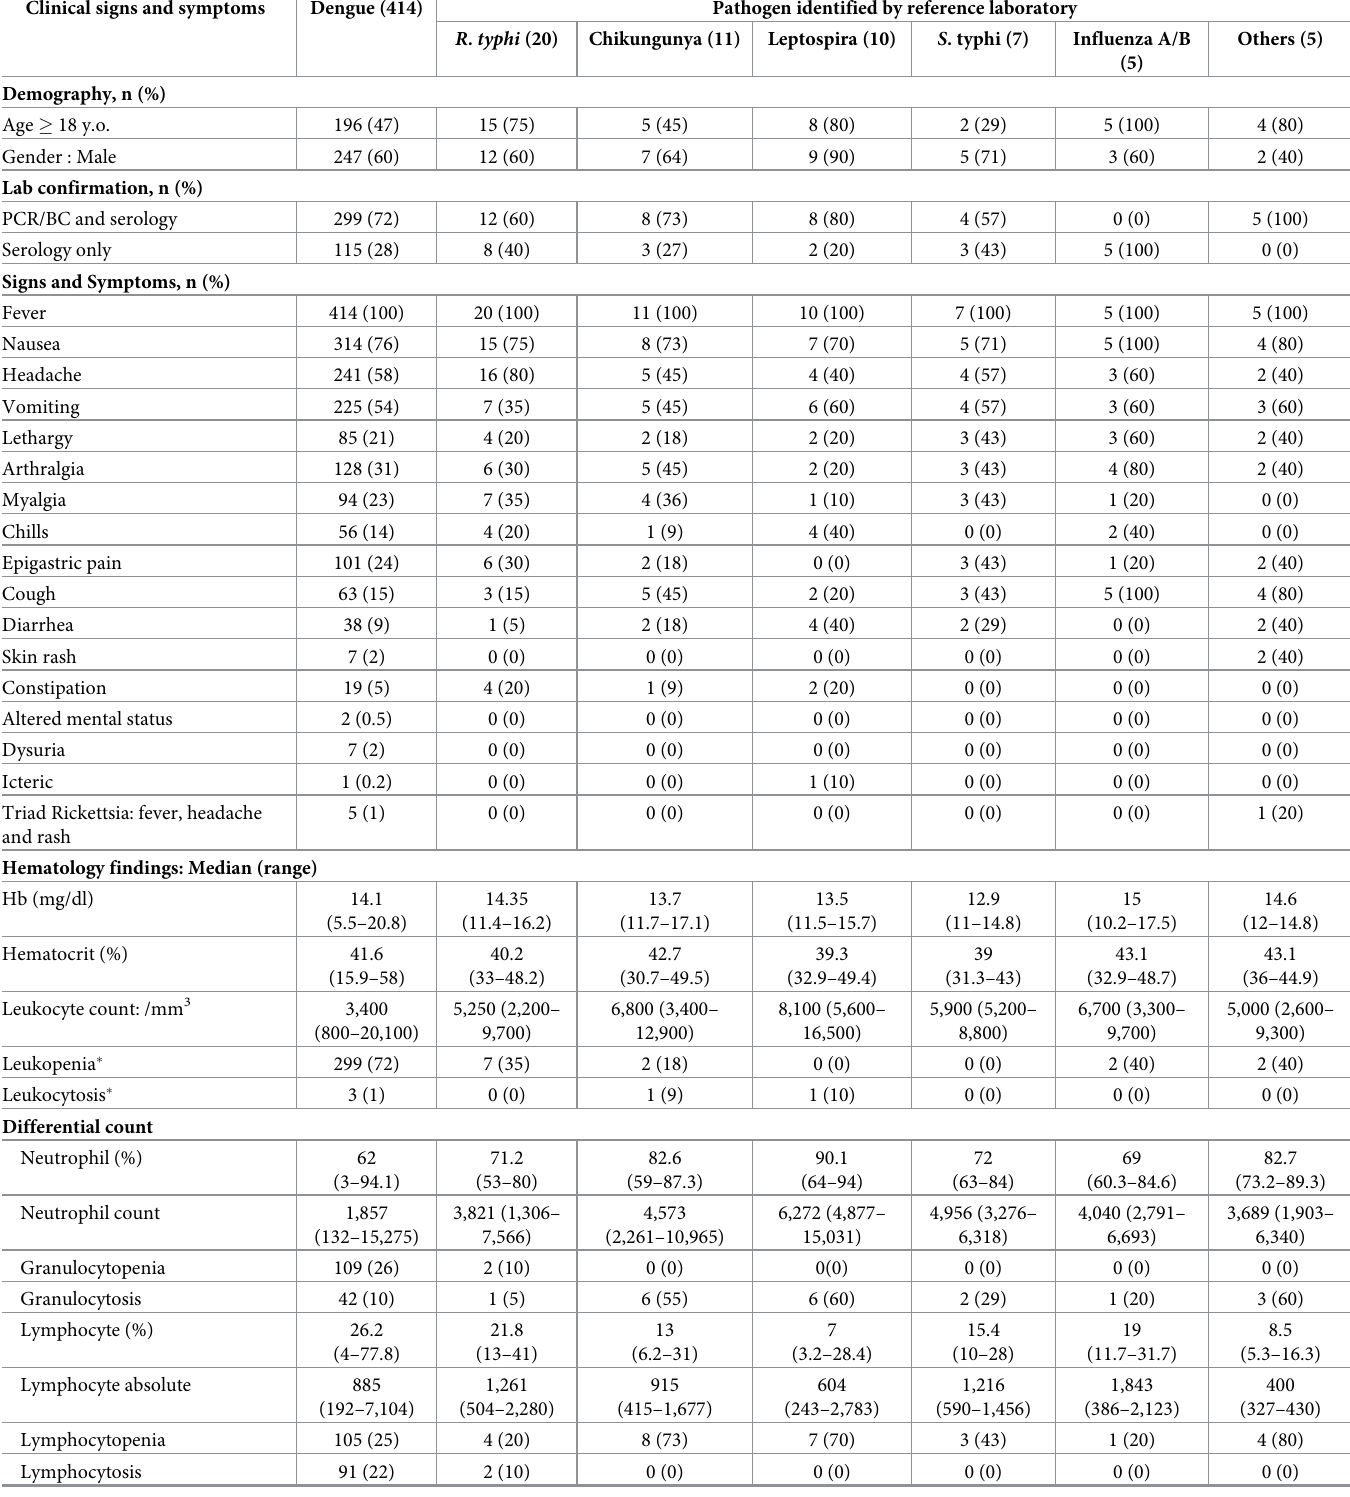
Table 2. Infection characteristics: Clinical signs and symptoms, hematology and biochemistry